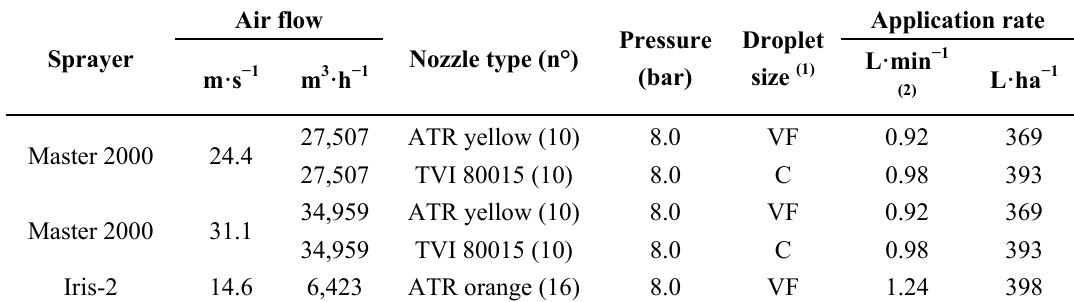
Table 1. Sprayer settings during the field